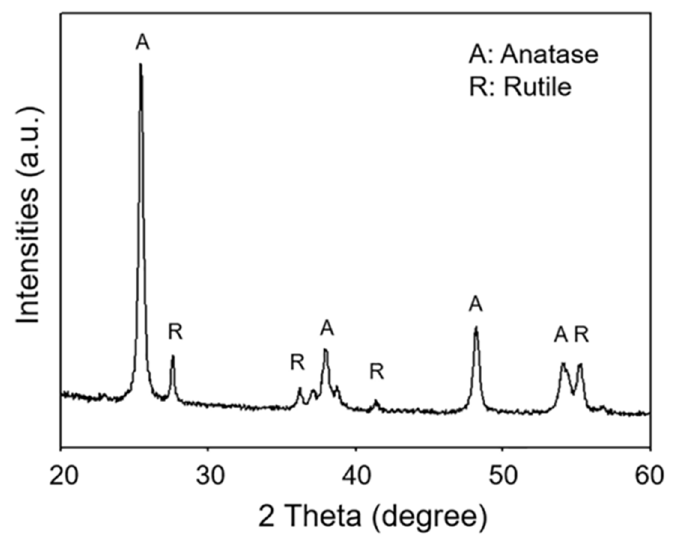
Figure 2. XRD pattern of P25-TiO 2